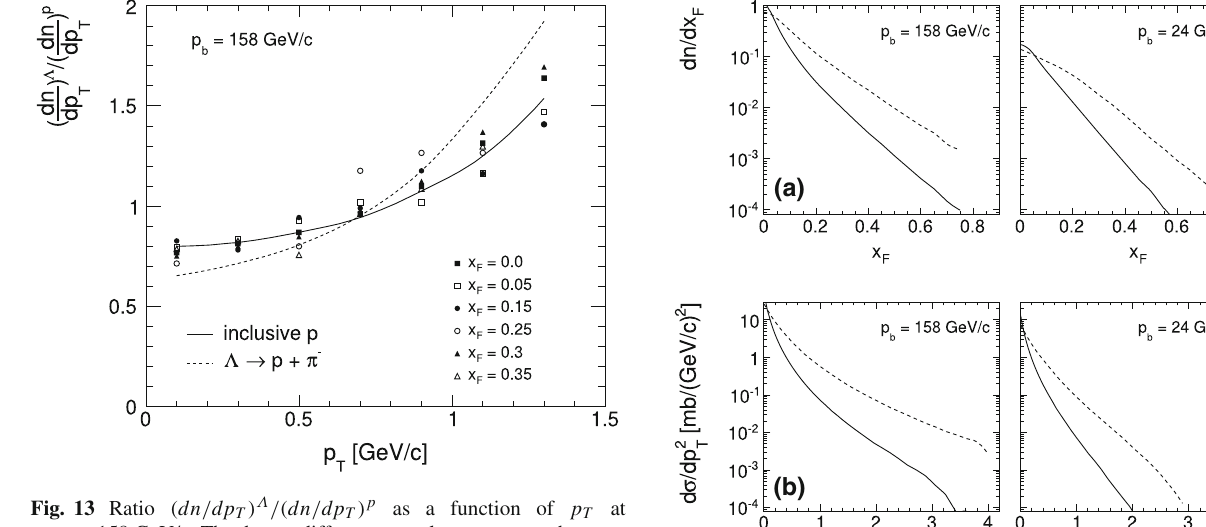
as a function of p 2 T T